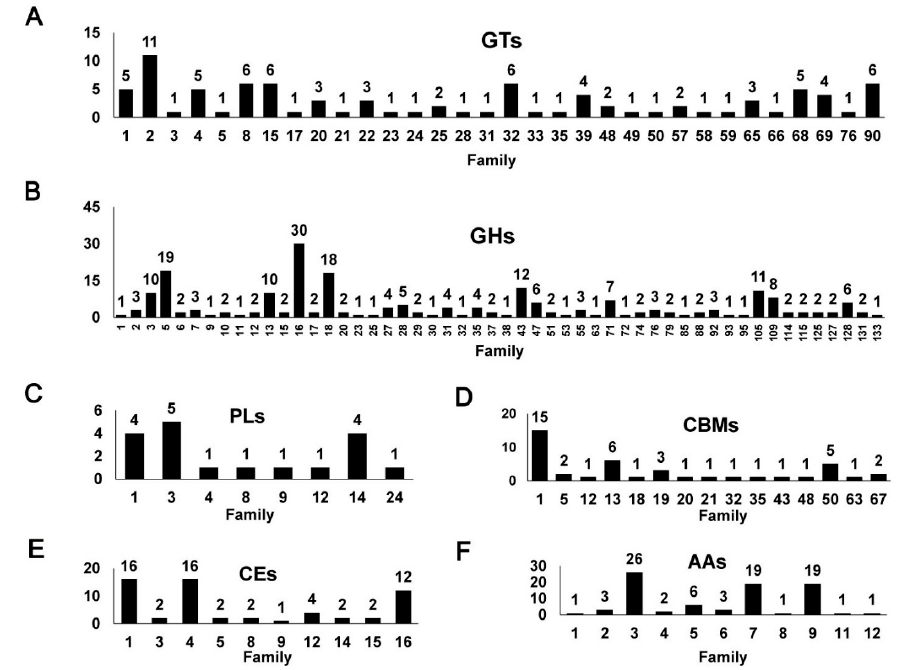
Figure 4. Number of CAZymes in F. elastica . Number of ( A ) GT families; ( B ) GH families; ( C ) PL families; ( D ) CBM families; ( E ) CE families; ( F ) AA families. AA, Auxiliary Activities; GH, glycoside hydrolase; GT, glycosyltransferase; CBM, carbohydrates- binding module; PL, polysaccharide lyase.